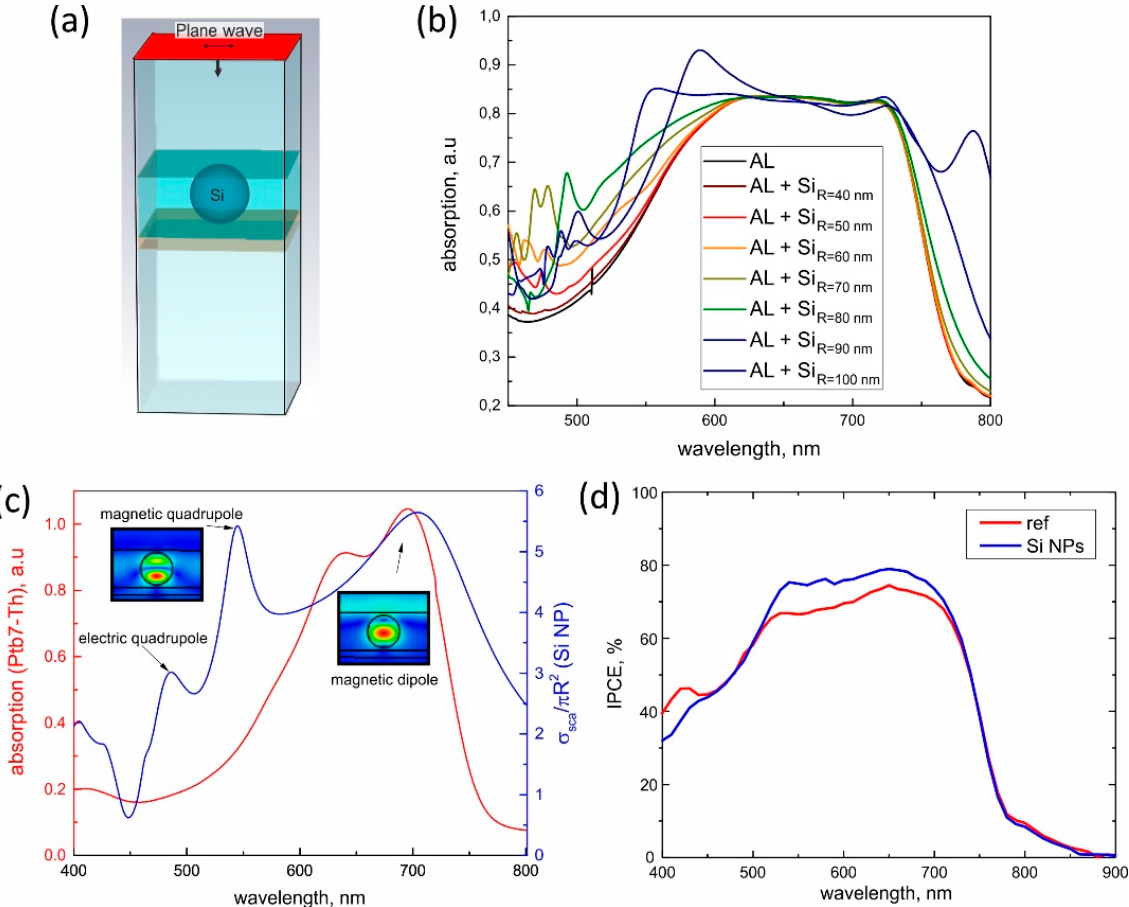
Figure 4. ( a ) A design for the numeral model. Red section corresponds to a port for the incident plane wave. ( b ) Numerically calculated spectra of absorption for the Ptb7-Th absorption layer (AL) without and with Si NP of different radii, from 40 nm to 100 nm. ( c ) Experimentally measured absorption spectrum of Ptb7-Th without Si NPs (red curve) and numerically calculated scattering efficiency of a single Si NP (with 150 nm diameter ) surrounded by Ptb7-Th (blue curve). Spectral peaks on the scattering spectrum correspond to different optical modes. ( d ) Experimentally measured incident photon-to-current efficiency (ICPE) for devices with and without Si NPs.